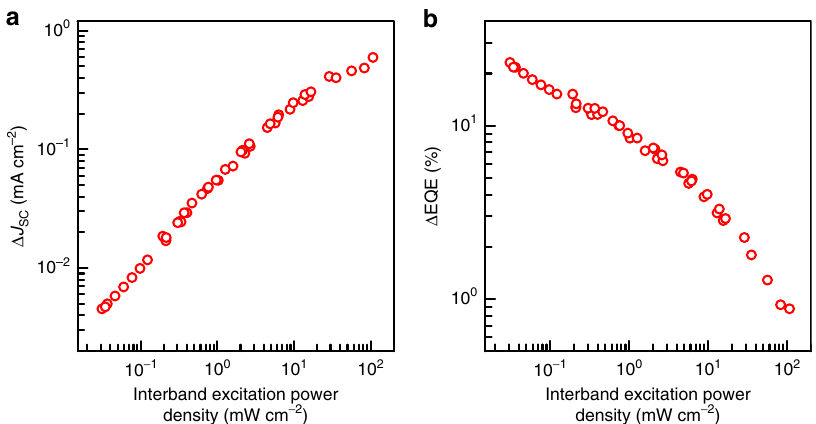
Fig. 1 Interband excitation power density dependence of two-step photon up-conversion current at 300 K. a Change in the short-circuit current density ( Δ J SC ). b Change in the external quantum ef fi ciency ( Δ EQE); the wavelength and excitation power density of the second intraband excitation light were 1300 nm and 300 mW cm − 2 , respectively